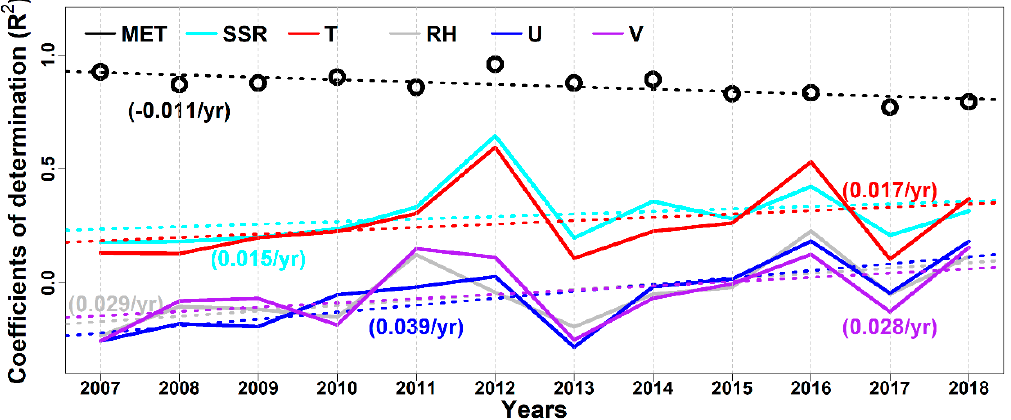
Figure 8. Coefficients of determination (R 2 ) between the baseline of daily MDA8 and baselines of meteorological variables from 2007 to 2018 (MET is R 2 between O 3 and all the five meteorological factors). Annotations in brackets indicate the increased rate of annual R 2 .